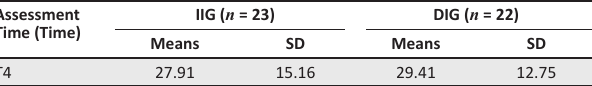
TABLE 1b: Means and standard deviations for the total score on the Revised Child Anxiety and Depression 30-Item Scale for the immediate intervention group ( n = 27) and delayed intervention group ( n = 25) from T1 to T4.